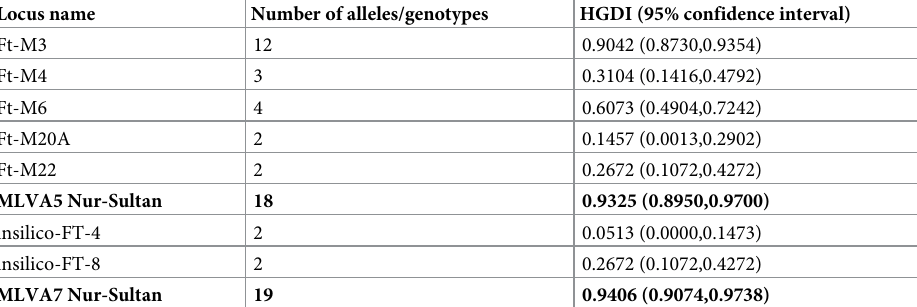
Table 2. Discrimination of VNTR loci for strains circulating in